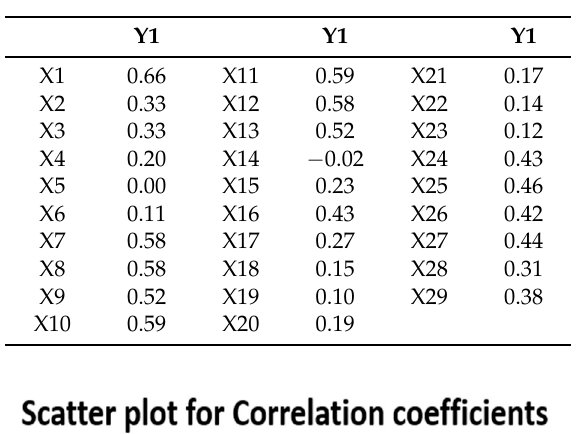
Table 9. Showing coefficients of correlations for all variables.